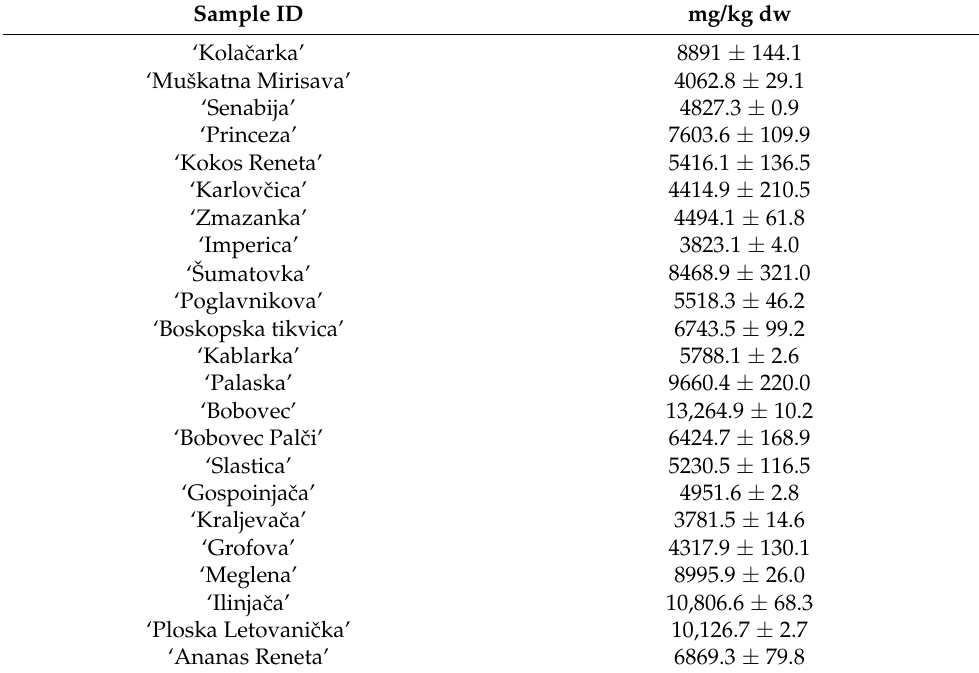
Table 3. Antioxidant activity (mmol TE/kg dw) of traditional apple varieties.